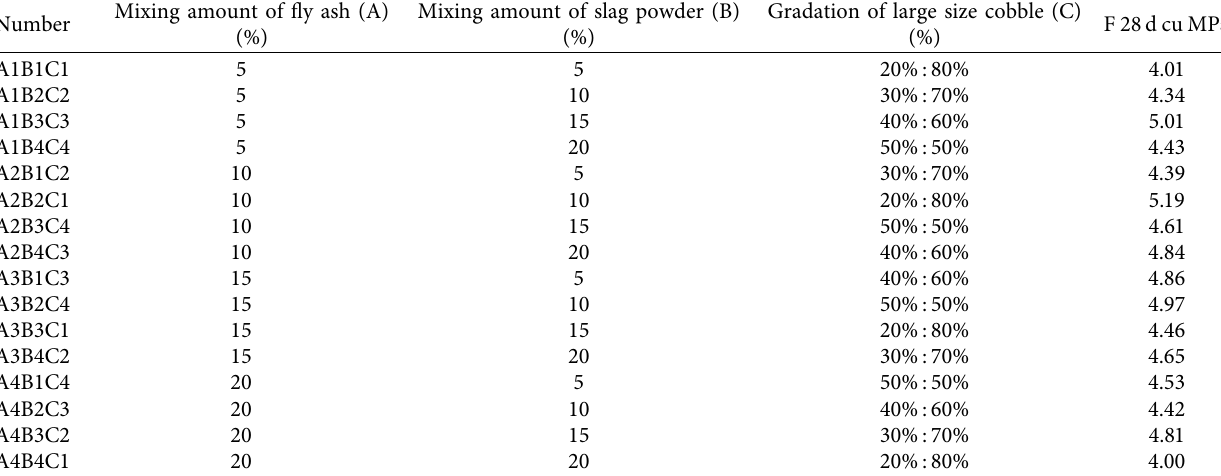
Table 2: Orthogonal experiment results.